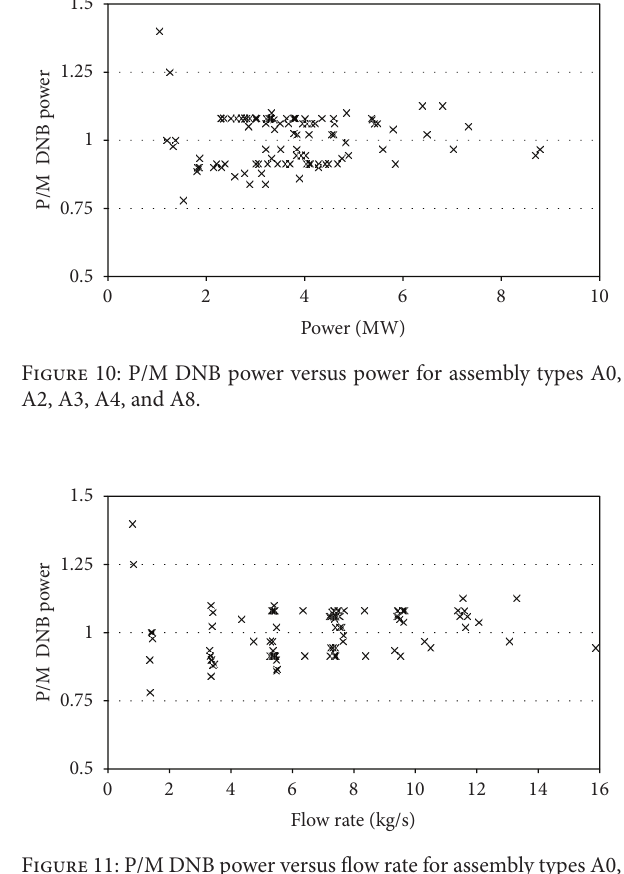
F 11: P/M DNB power versus �ow rate for assembly types A0, A2, A3, A4, and A8.